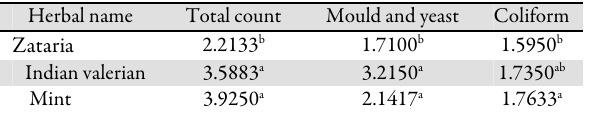
Tab. 8. The average comparison of microbial load of the studied medicinal